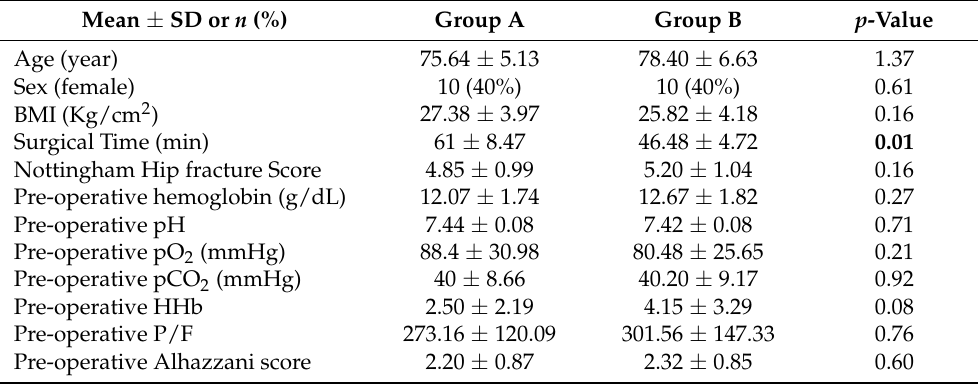
Table 2. Pre-operative study group data divided by surgical approach (U Mann–Whitney test except for Fischer test for sex, HHb: hemoglobin subunit beta; BMI: Body Mass